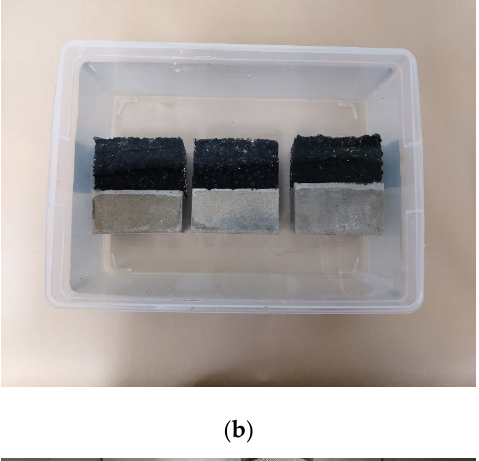
Figure 5. APC and LMC pavement specimens; ( a ) a double-sided waterproofing sheet, ( b ) surface of waterproofing sheet, ( c ) LMC pavement specimen with applied waterproofing sheet, ( d ) APC pavement specimen with applied waterproofing sheet.